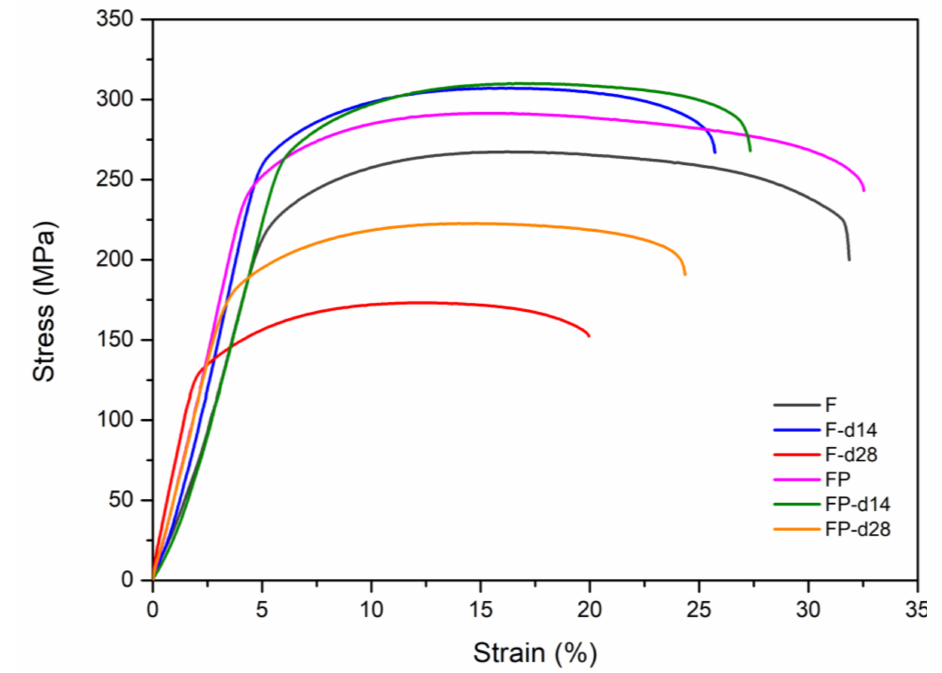
Figure 13. Stress–strain curves of F and FP before and after immersed in SBF.